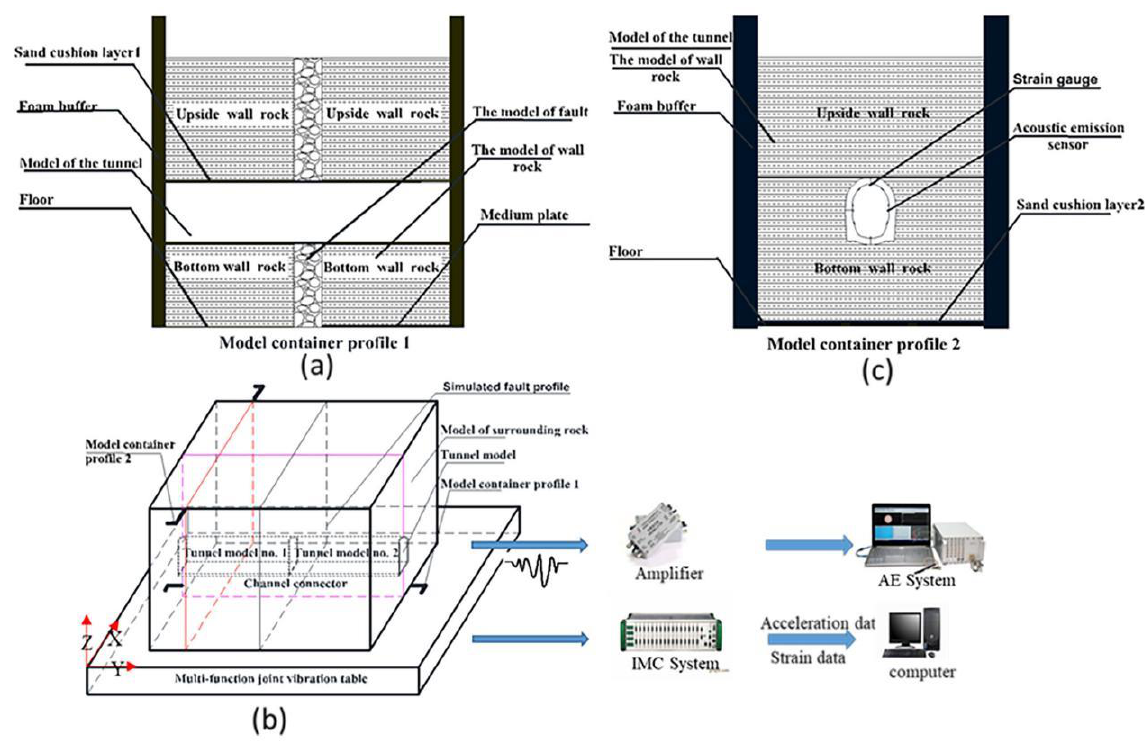
Figure 1. Schematic of experimental system: ( a ) side view of the model; ( b ) the overall design schematic of the experimental system; ( c ) the main view of the model.